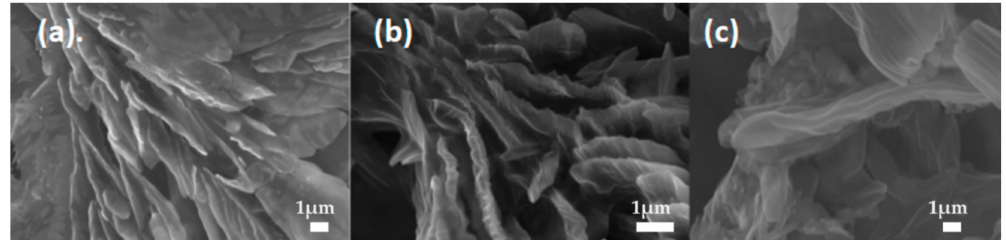
Figure 3. The ex situ analysis of the MOF-801 samples formed in 20 mL of water and 40 mL of ethanol after reticulation for ( a ) 15 s, ( b ) 30 min and ( c ) 3